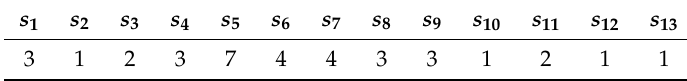
Table 6. The execution number of each statement in Program